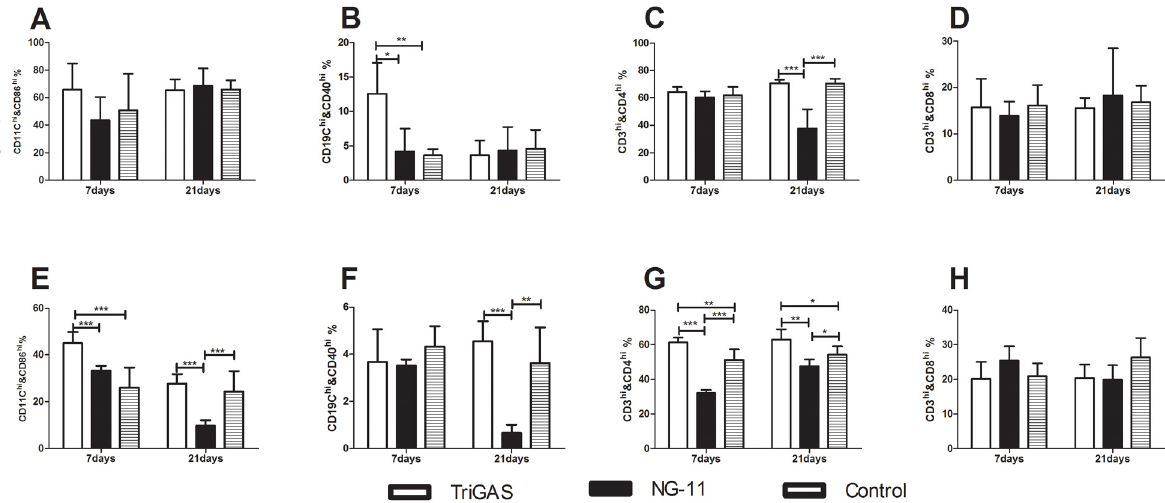
Fig 3. Lab-attenuated RABV induces early activation of immune cells while wt RABV evades immune activation. Groups of dog were IM injected with attenuated TriGAS or wt NG-11. Flow cytometric analysis of activation status of DCs and B-cells, and number of CD4 and CD8 T-cells in the lymph node (A-D) and in the blood